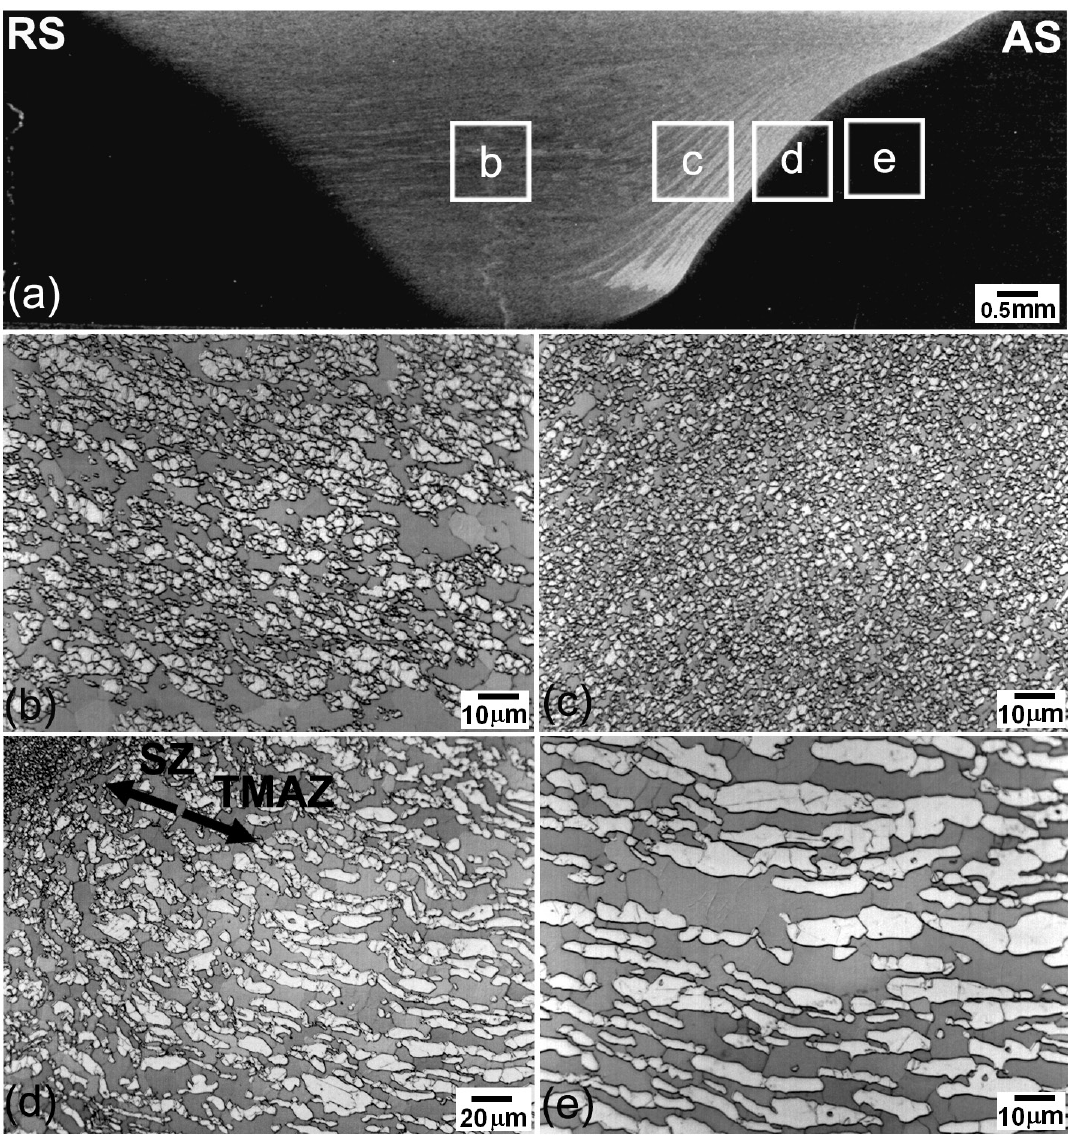
Fig. 8. Optical microscopy cross sections of UNS S32750 SDSS FSW joint: (a) macrograph of welded joint, (b) SZ, (c) SZ-AS, (d) SZ/ TMAZ-AS interface, and (e) details of